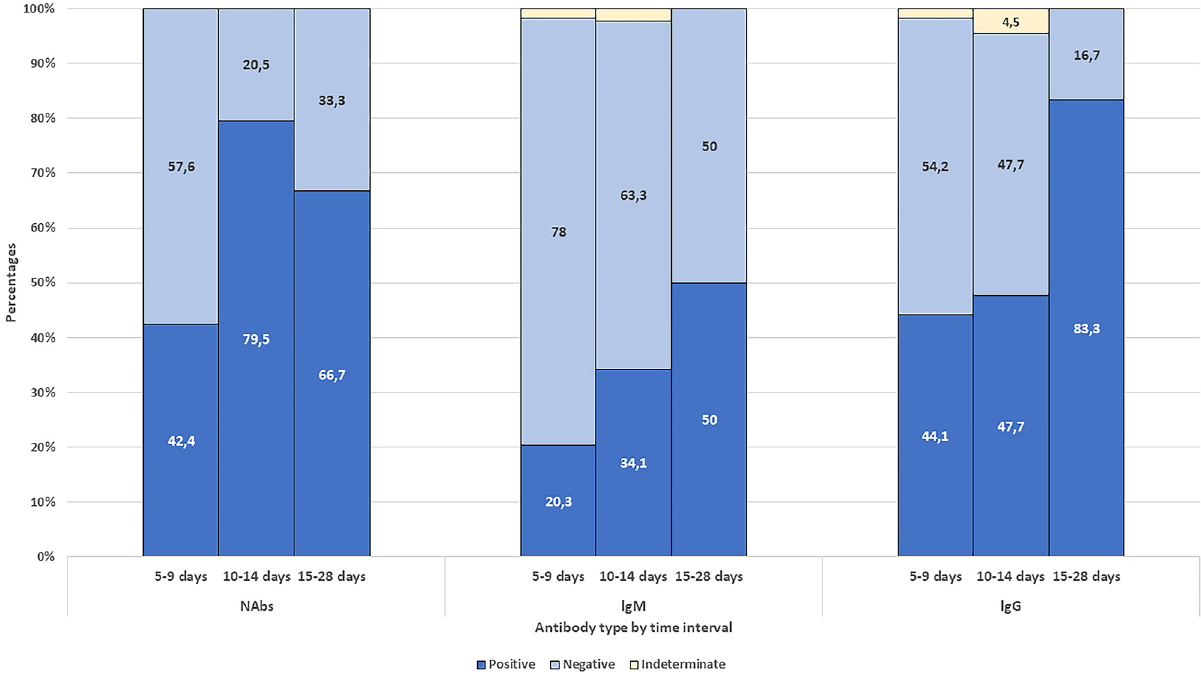
Figure 3: Seroconversion characteristics of severe acute respiratory syndrome-Coronavirus-2 specific neutralizing antibody (NAb), immu- noglobulin M (lgM), and immunoglobulin G